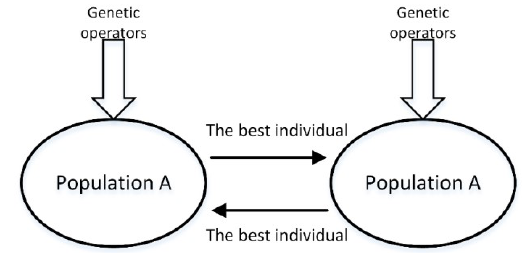
Figure 1. Map of chromosome migration between